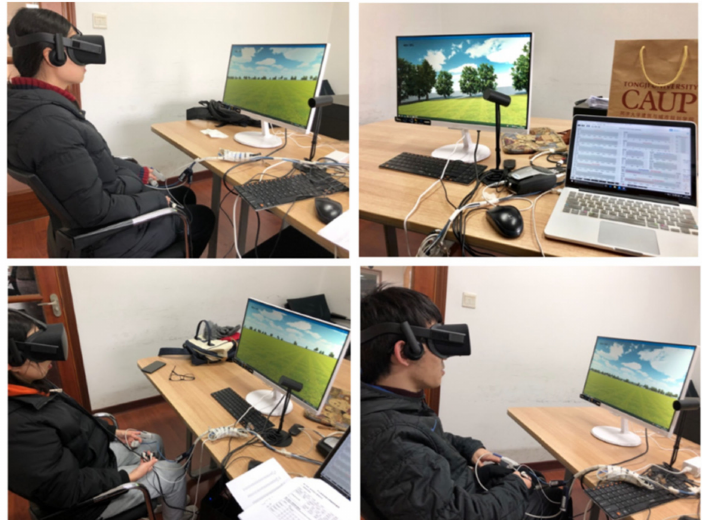
Figure 4. Participants were immersed in a virtual natural